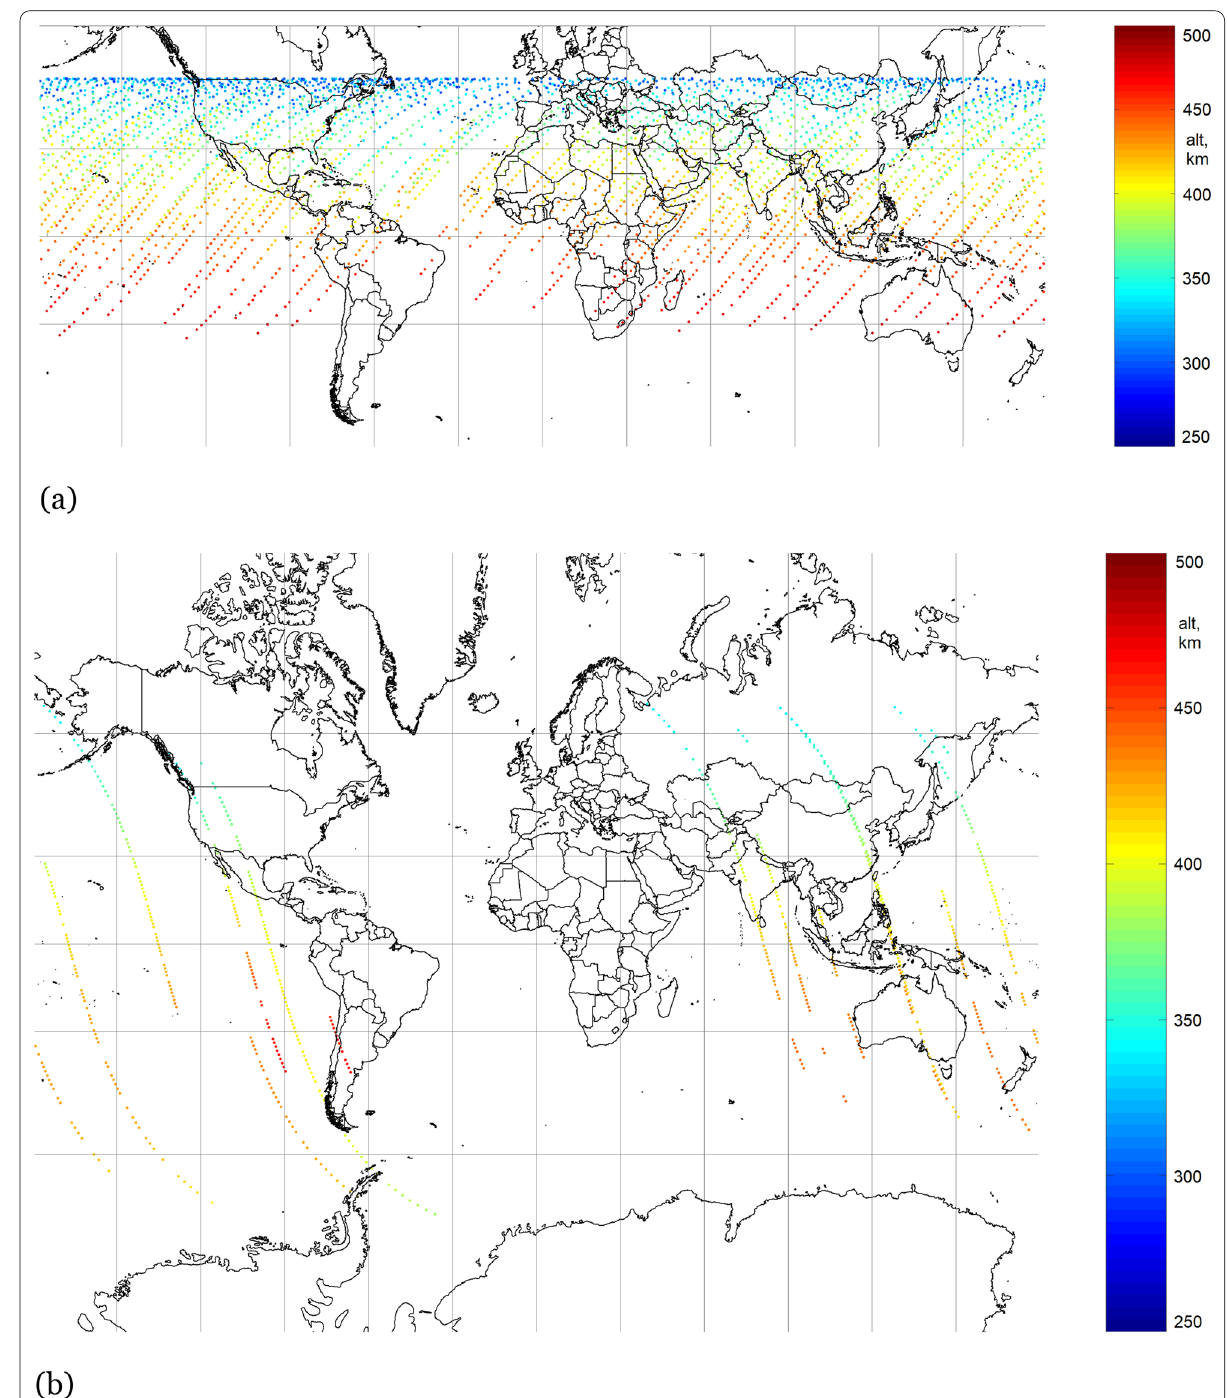
Fig. 1 Spatial distribution of the selected measurements by the Kosmos-49 ( a ) and Kosmos-321 ( b ) satellites. The color scale denotes the flight altitude in